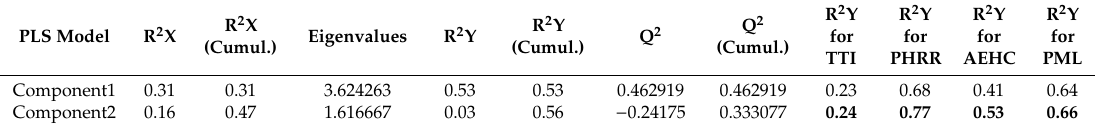
Table 7. Fitted parameters for the partial least square (PLS) model to predict the flammability (TTI, PHRR, AEHC, PML) using: the amount of terpenoids (MT_tot, ST_tot, MTox_tot, STox_tot, Tot_Terp) contained in each sample ( µ g), the FMC, the treatment x clone (4 levels: resistant control, RC, resistant infected, RI, susceptible control, SC, susceptible infected, SI) as predictors. The model selects two components and includes the dummy variable ‘alive vs. dead’ samples to highlight the importance of the dead samples (4 samples belonging to the SI treatment) in the prediction of flammability (N = 36). The total model fit (R 2 Y) and the partial model fit for the predicted flammability variables are highlighted in